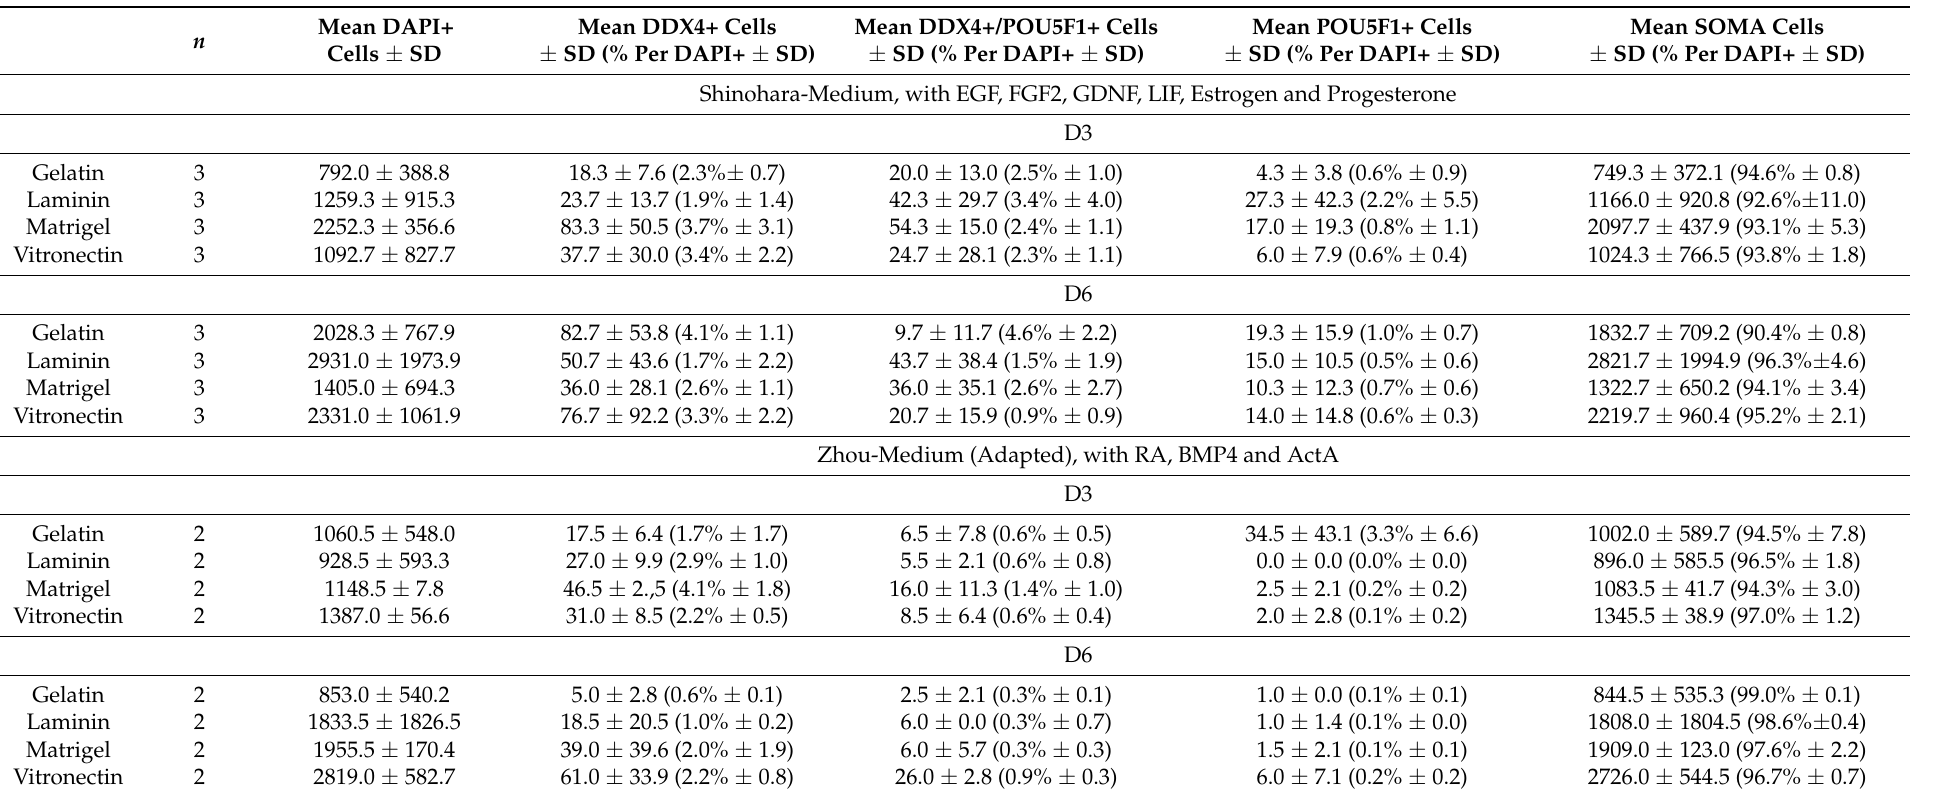
Table 1. Quantification of male hFGCs after culture in the different